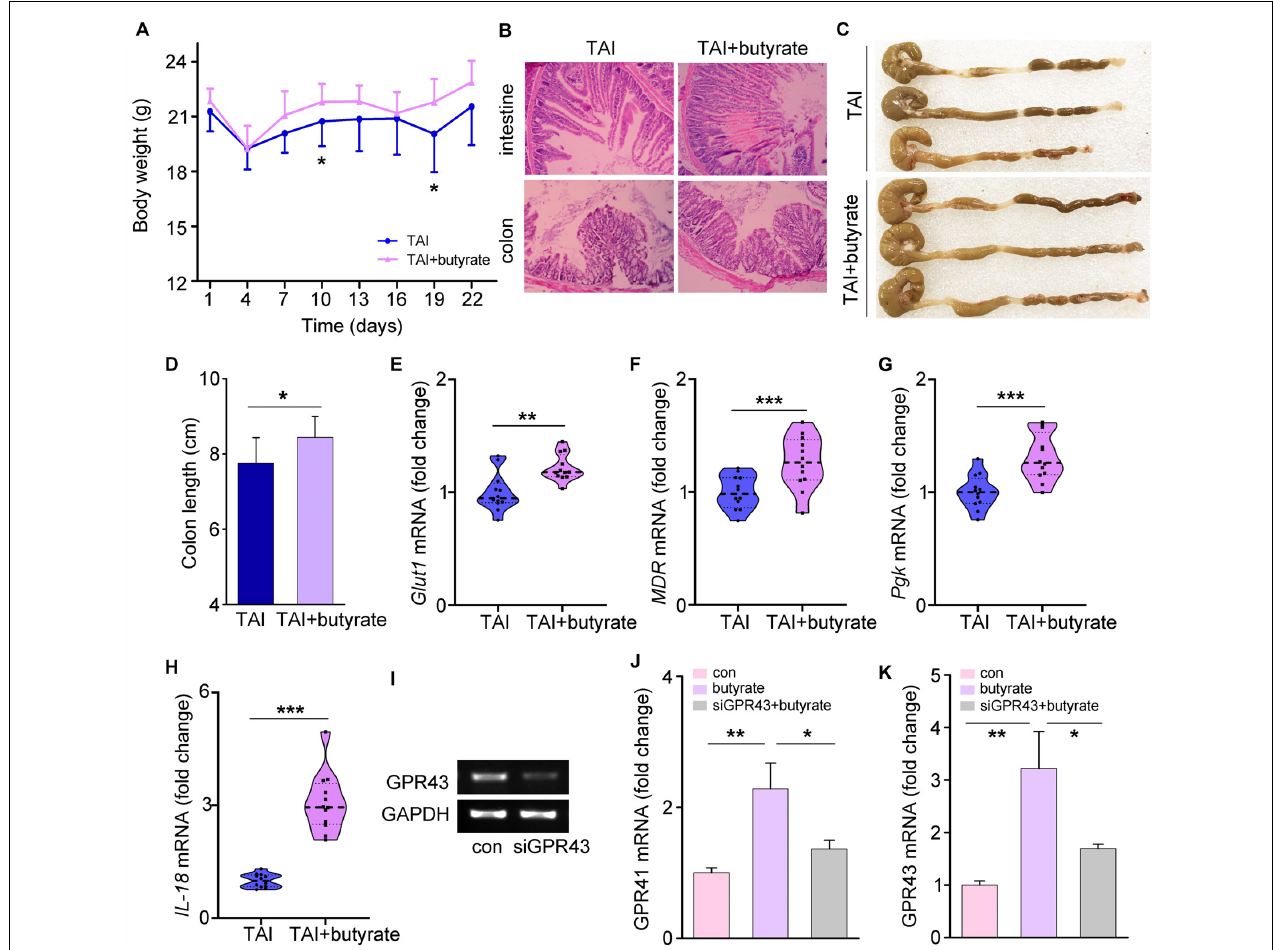
FIGURE 6 | Butyrate educates P80-aggravated GI injury involving GPCRs. (A) The body weight of mice was measured after 12 Gy TAI using two-way group ANOVA (* p < 0.05), n = 12 per group. (B) The morphologies of the intestine (upper panel) and colon (lower panel) of mice were shown by HE staining. (C,D) The length of colon tissues of mice was measured at 30 days after 12 Gy TAI. Significant differences are indicated: * p < 0.05; Student’s t -test, n = 12 per group. (E–H) The expression levels of Glut1 (E) , MDR (F) and Pgk (G) in small intestines and IL-18 (H) in colon tissues of mice were examined by qRT-PCR. Significant differences are indicated: ** p < 0.01, *** p < 0.001; Student’s t -test, n = 12 per group. (I) The expression level of GPR43 in the HIEC-6 cells with butyrate and with or without knockdown of the GPR43 expression was examined by quantitative PCR. (J,K) The expression levels of GPR41 (J) and GPR43 (K) in HIEC-6 cells with or without siGPR43 transfection were examined by qRT-PCR. Significant differences are indicated: * p < 0.05, ** p < 0.01; Student’s t